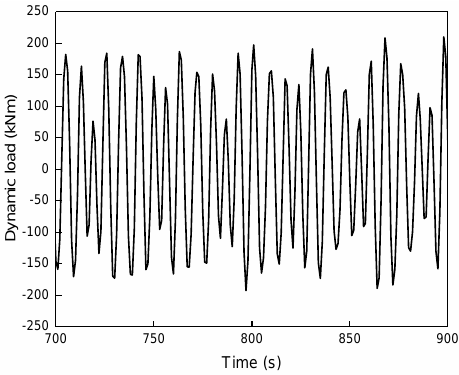
Figure 6. Cyclic dynamic load of SW (H S = 3.25 m, T P = 9.5 s).